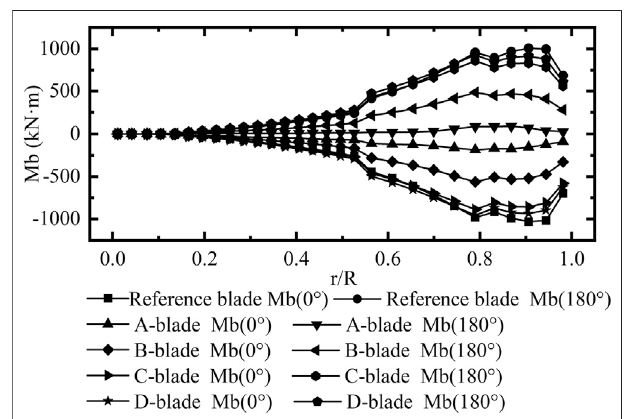
FIGURE 12 | The optimized fl apping bending moment of the blade root along the span.